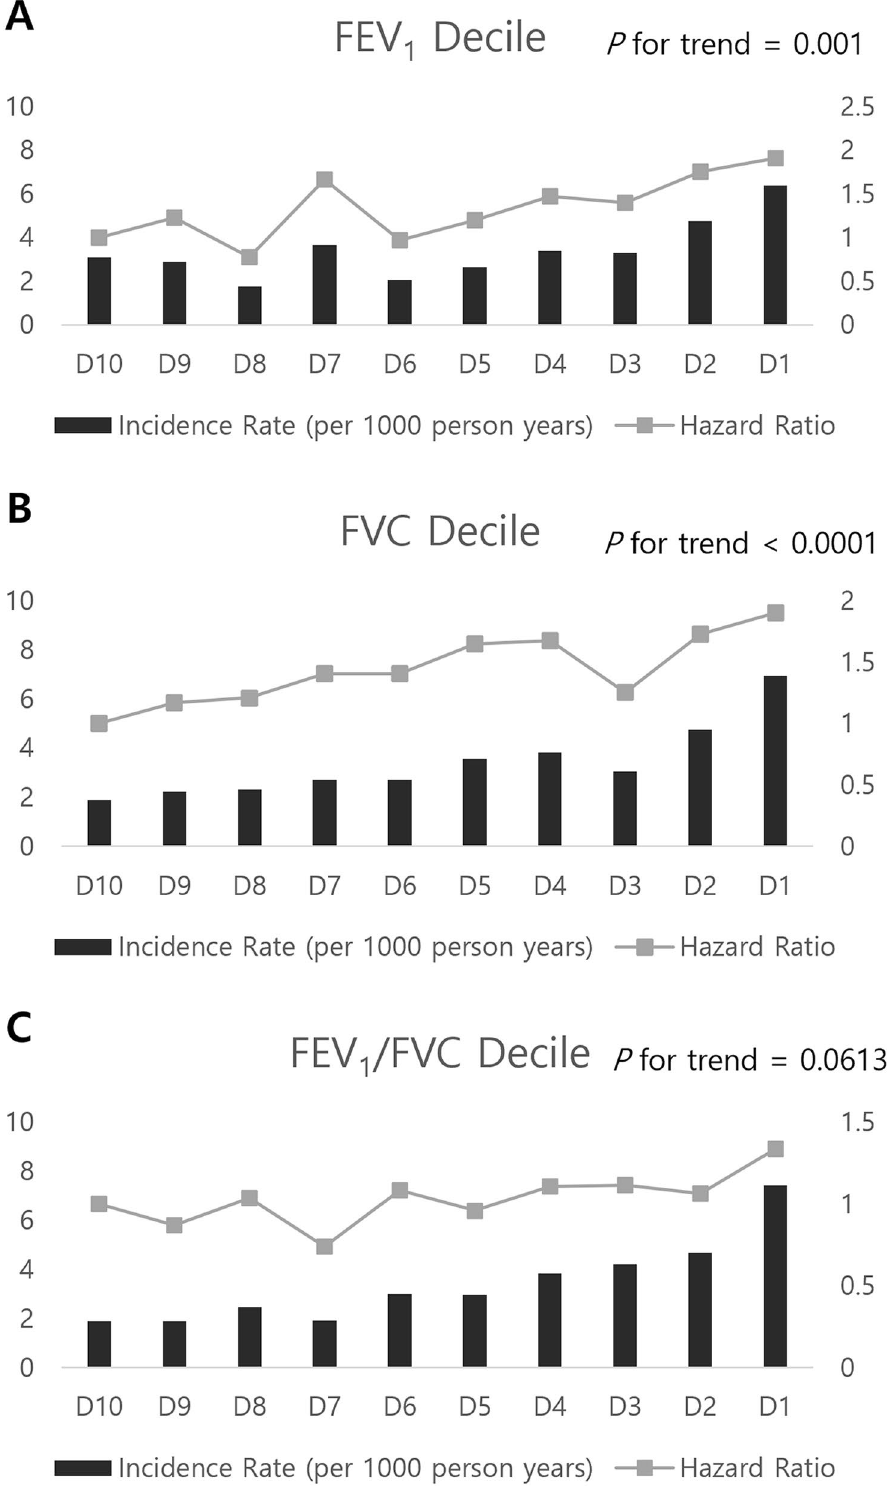
Figure 1. Incidence rate and hazard ratio of atrial fibrillation according to the decile of lung function measurements. ( A ) FEV 1 , ( B ) FVC, and ( C ) FEV 1 /FVC. All HRs adjusted for covariates including age, sex, BMI, household income, education, exercise, alcohol consumption, smoking, hypertension, DM, dyslipidemia, white blood cell count, eGFR, stroke, IHD, and